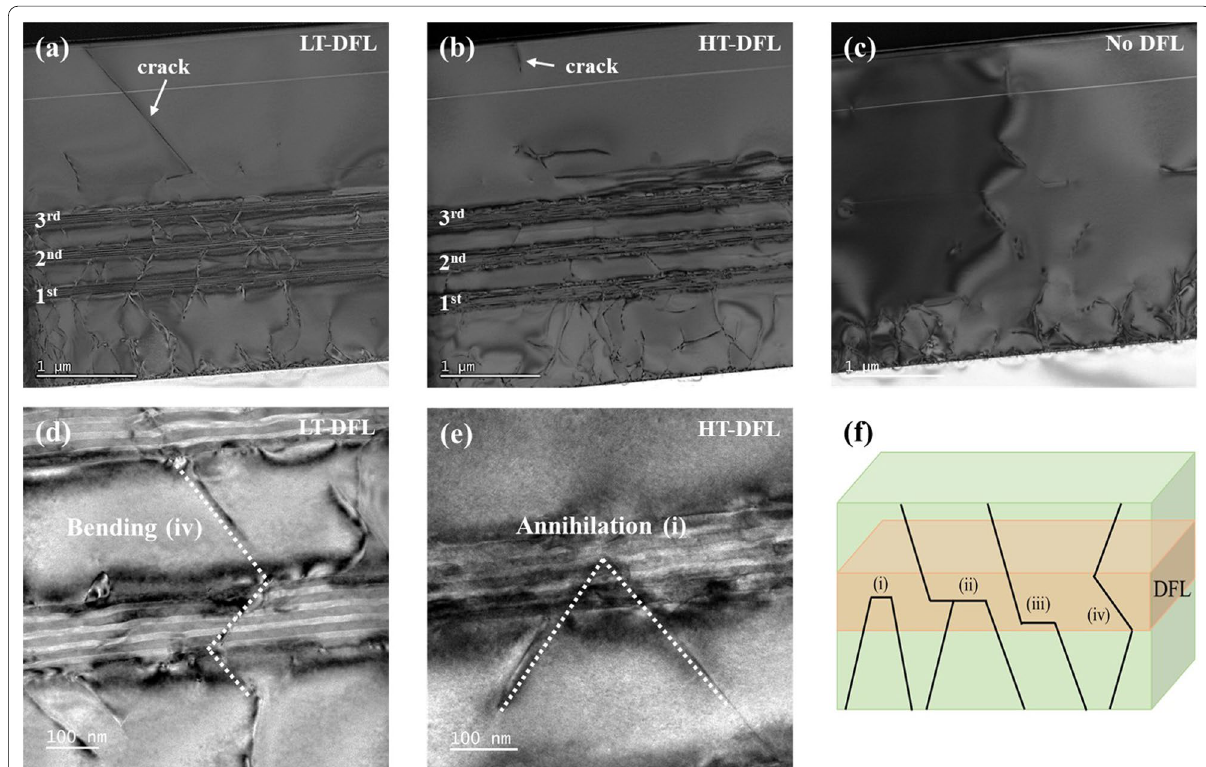
Fig. 3 Cross‑sectional TEM images and a schematic illustration of the dislocation motion. a , d LT‑DFL and b , e HT‑DFL, c depicts the TD propagation in the control sample which does not have DFLs, f is a schematic illustration of interaction and movement of TDs